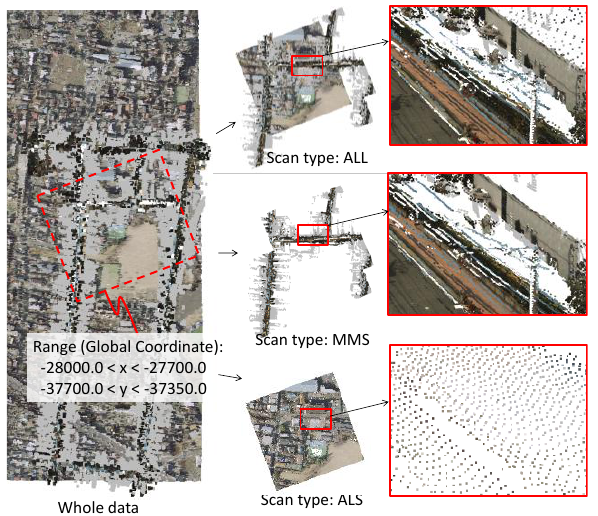
Figure 6. A result of searching by measurement system and range from multiple point cloud files